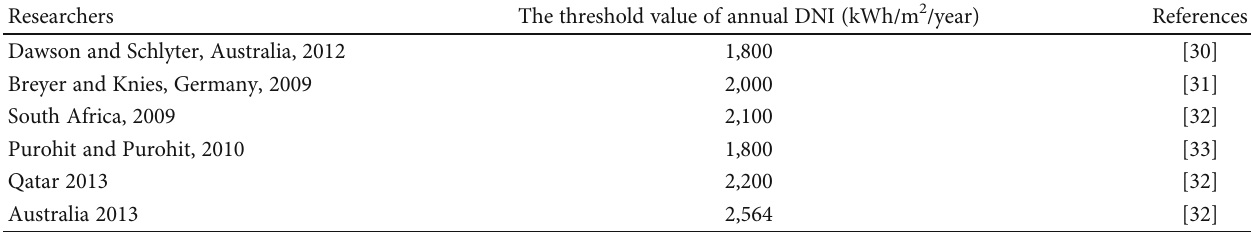
Table 1: Threshold values of DNI in some countries.